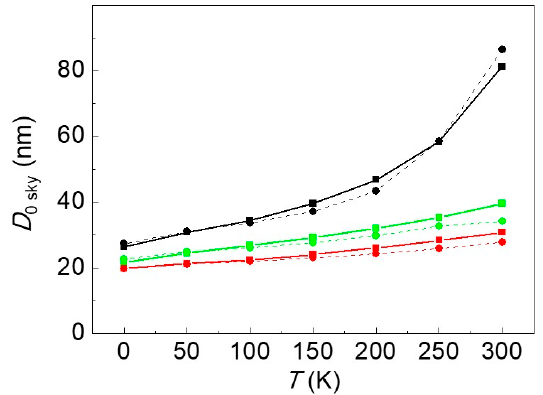
Figure 2. Comparison between D sky obtained numerically (solid lines with squares) and D sky calculated according to Equations (22c) and (22d) (dashed lines with circles). Black lines: D sky at μ 0 H ext = 0 mT. Green lines: D sky at μ 0 H ext = 25 mT. Red lines: D sky at μ 0 H ext = 50 mT.